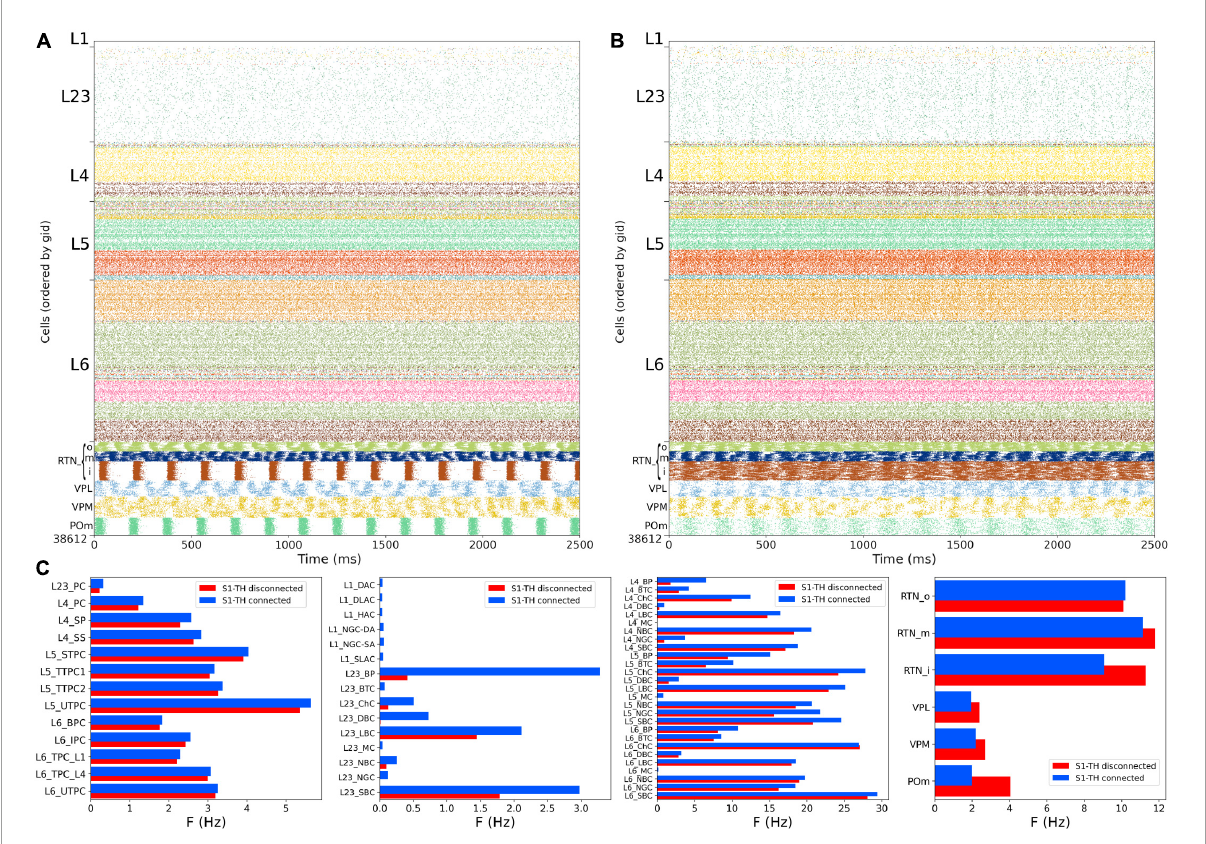
FIGURE8 NetPyNE S1 and thalamic circuit response with low extracellular calcium ( in vivo -like asynchronous states). (A) Spiking raster plot of spontaneous activity with only intracortical and intrathalamic connections ( S1-TH disconnected ). (B) Spiking raster plot of the fully connected circuit model, including bidirectional connections between S1 and thalamus ( S1-TH connected ). (C) Comparison of mean firing rates of each of the 55 S1 and 6 thalamic m-types without ( S1-TH disconnecte d) and with ( S1-TH connected ) bidirectional thalamocortical